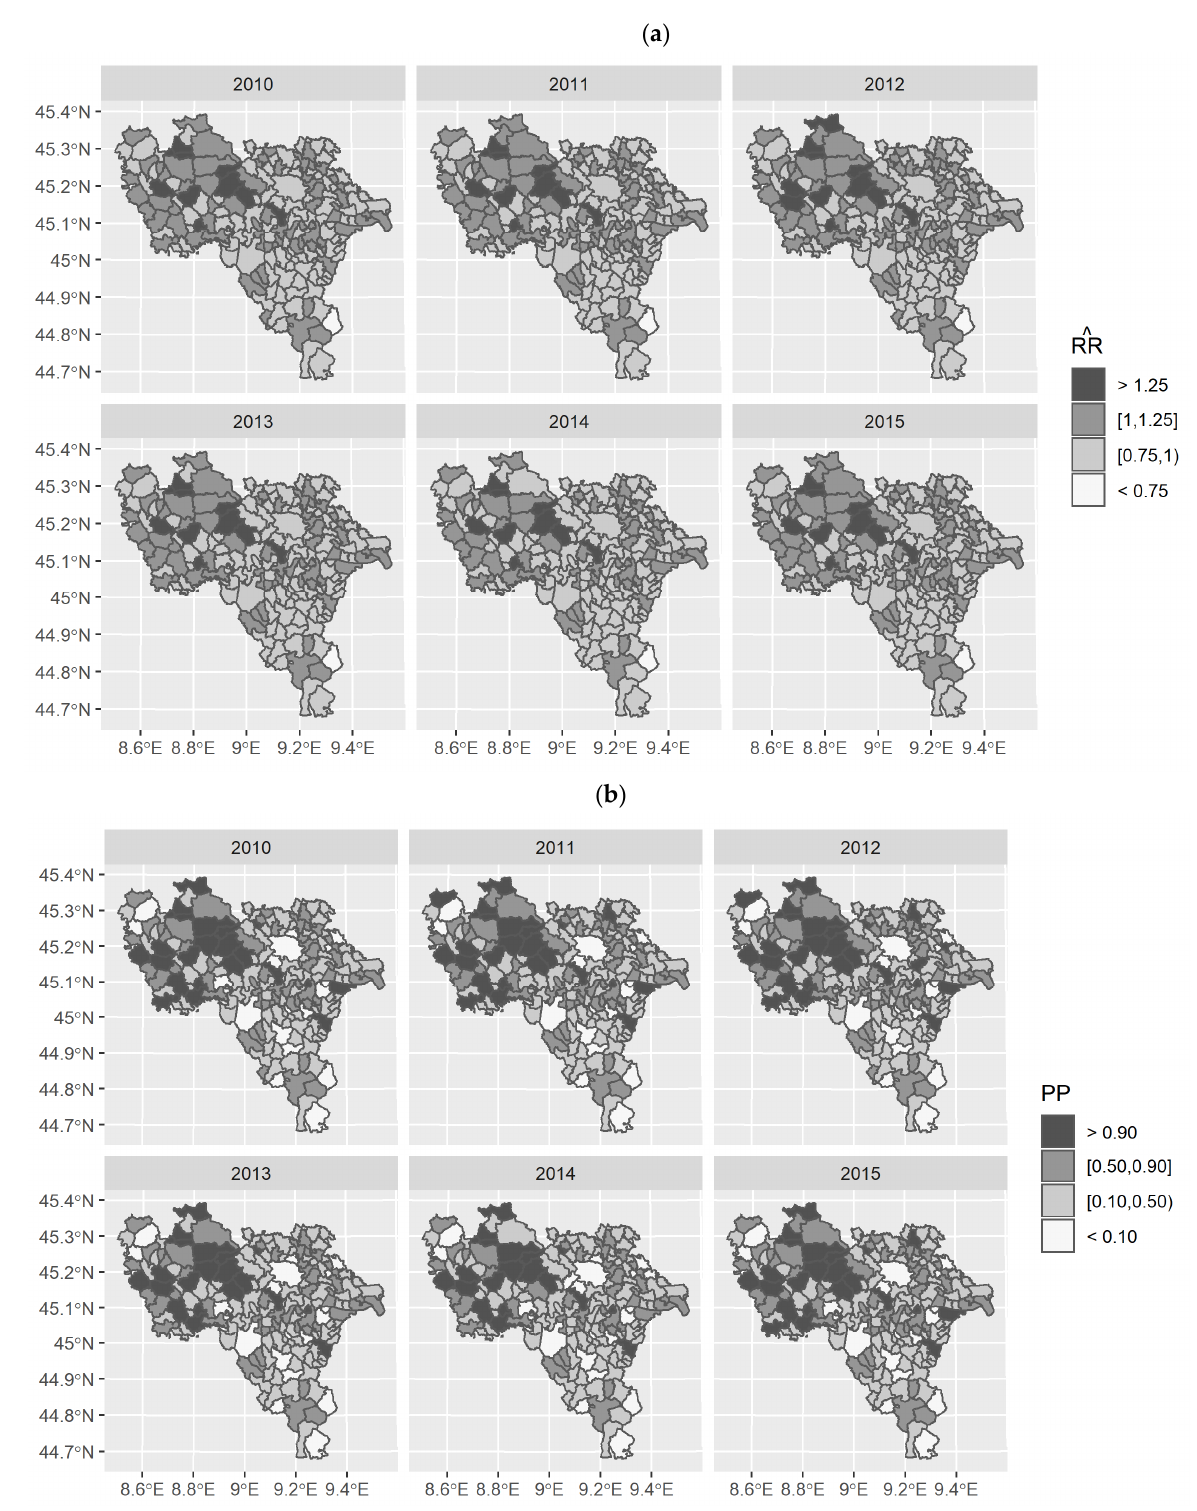
Figure 5. Spatio-temporal distribution of relative risk (RR) estimates provided by the Log-linear with spatially unstructured random intercept and posterior probabilities (PP). ( a ) RR estimates are “temporally” smoothed by the random intercepts posed on each municipality during the study period. Darker municipalities have a higher RR estimate, while those with whiter colours show a smaller risk estimate given by the marginal posterior distribution of RR for each area. ( b ) PP are calculated as p ( ˆ RR i > 1 ) . Areas marked with a darker colour are more likely to be high-risk municipalities; conversely, areas marked with a whiter colour are likely to show a smaller risk.